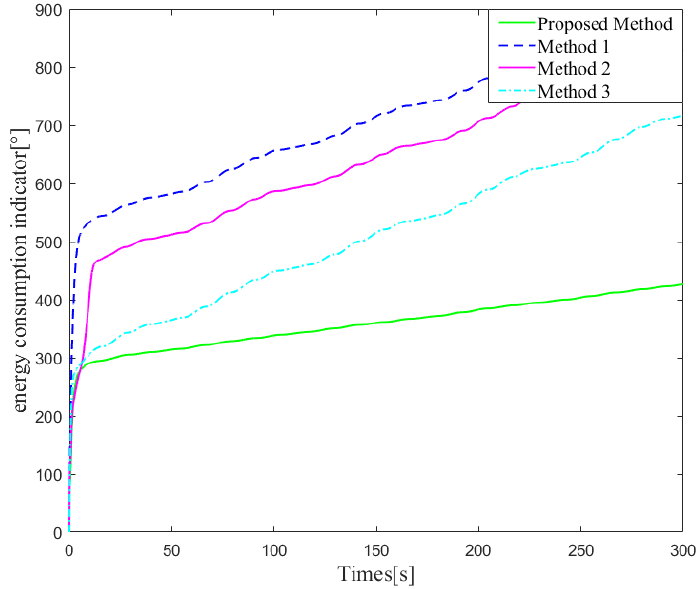
Figure 15. The energy consumption comparsion. Table 8. Data analysis of steady-state for Case 2 (from 50s to 300s).